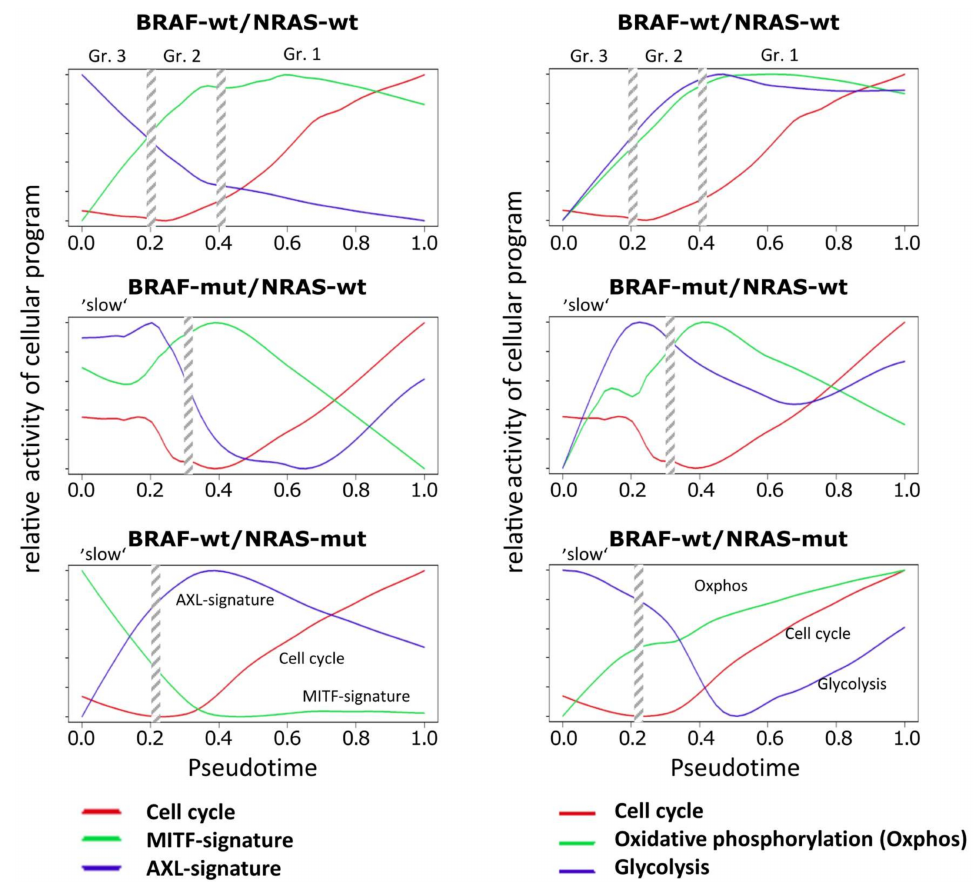
Figure 3. Relative activity of cellular programs of cell cycle, MITF, AXL, oxphos and glycolysis signatures along PT. Melanoma short-term cultures were analyzed by single-cell RNA-seq and subjected to PT analysis using the Wanderlust algorithm and analysis of relative reactivity profiles of cell cycle, MITF, AXL, oxphos and glycolysis signatures. Vertical streaked bars indicate the boundaries of the three different cell subpopulations in wt/wt cells or the two different cell populations in BRAF-mut/NRAS-wt and BRAF-wt/NRAS-mut cells as indicated in Figure